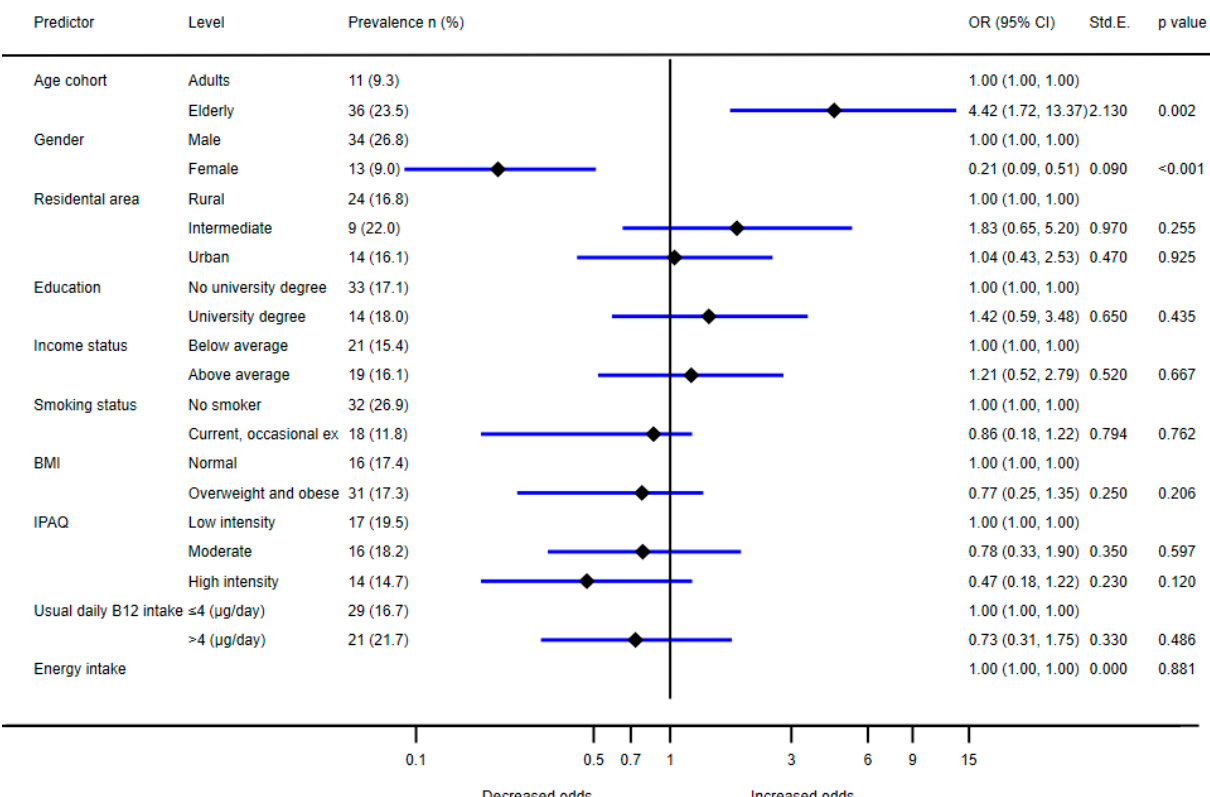
Figure 4. Association between prevalence of vitamin B12 deficiency (serum vitamin B12 concentra- tion < 221 pmol/L and serum homocysteine > 15 µmol/L) and age, sex, residential area, education, financial status, body mass index (BMI), IPAQ (International Physical Activity Questionnaire) score, usual intake of vitamin B12, and usual daily energy intake.